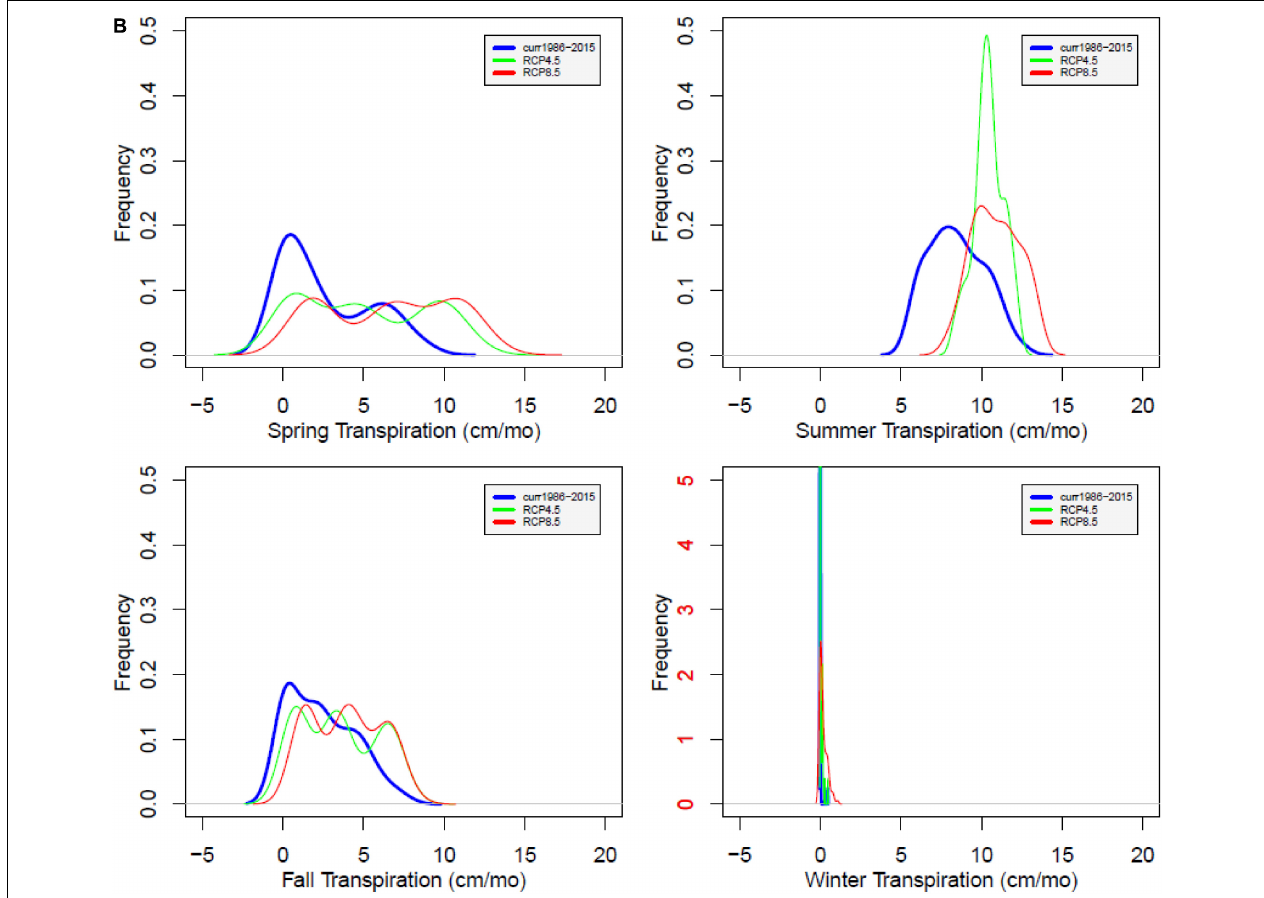
FIGURE 5 | Probability distribution of simulated transpiration at WS18 (A) and WS27 (B) under future climate compared to values under current climate by season. Current (blue), RCP4.5 (green), and RCP8.5 (red). The red color of the labels in winter shows different range of y -axis compared to the other